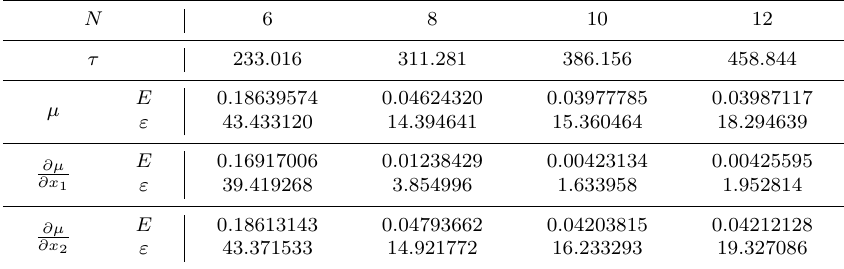
Table 6. The total elapsed CPU time τ , the aggregate relative error E , the efficiency number ε = τE for Case 3. N 6 8 10 12